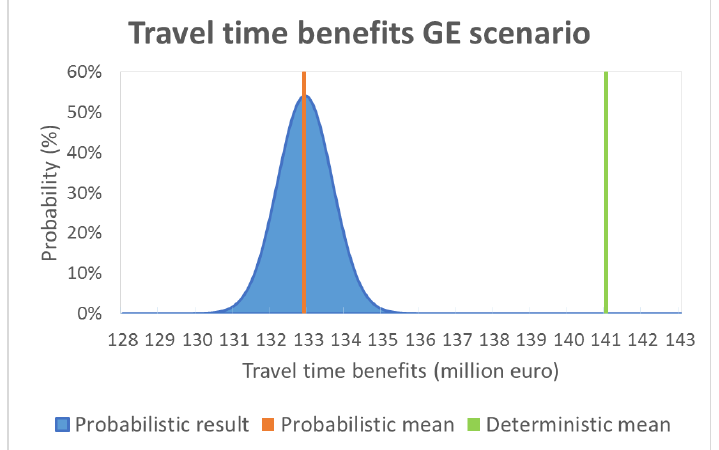
Figure 3. Uncertainty in estimations of travel time savings in the GE